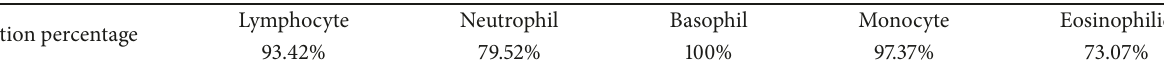
Table 3: Percentages of correlation by type of white blood cell.